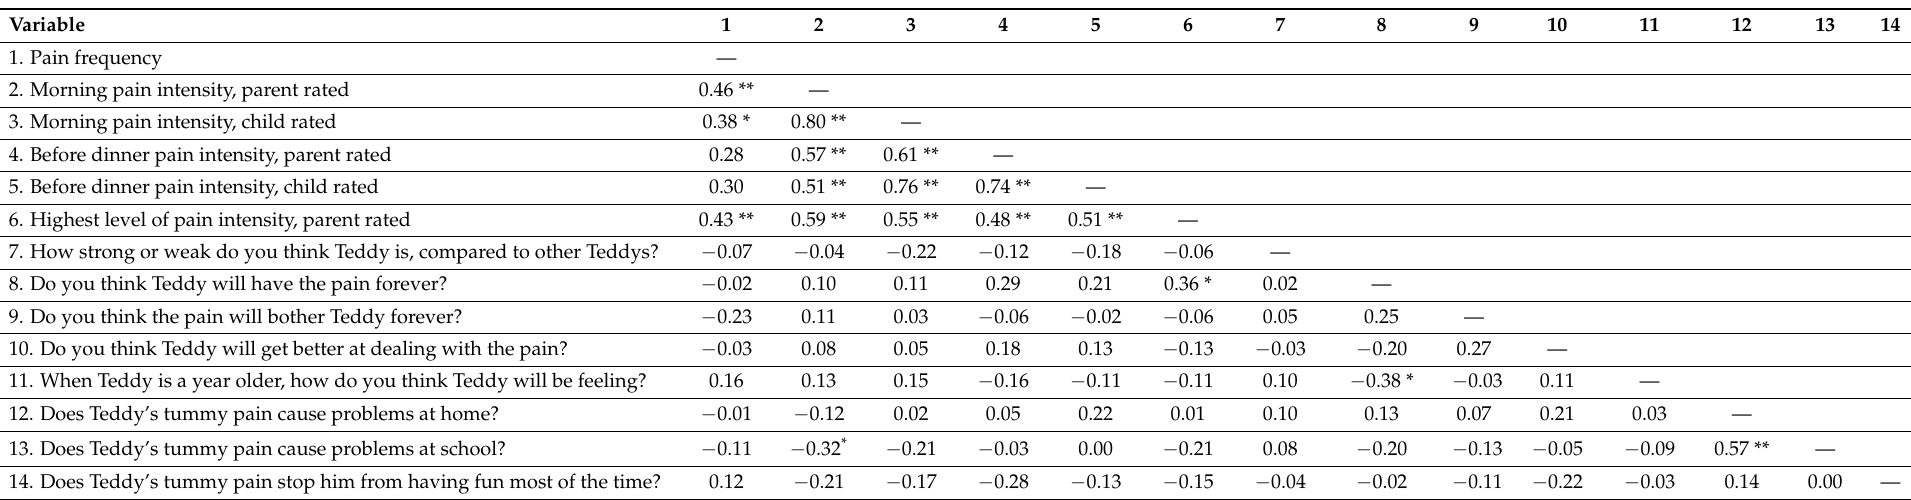
Table 3. Correlations among Children’s Pain Frequency, Intensity, and